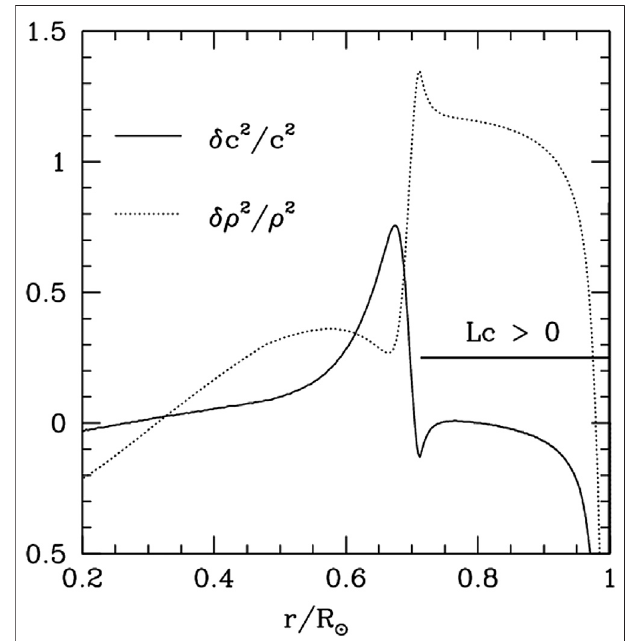
FIGURE 3 | log T as a function of log P in the solar atmosphere for the non-local (dashed-line) and local convection models of the Sun (dotted-line). The inverse triangles are the Harvard-Smithsonian reference atmosphere (Gingerich et al., 1971).